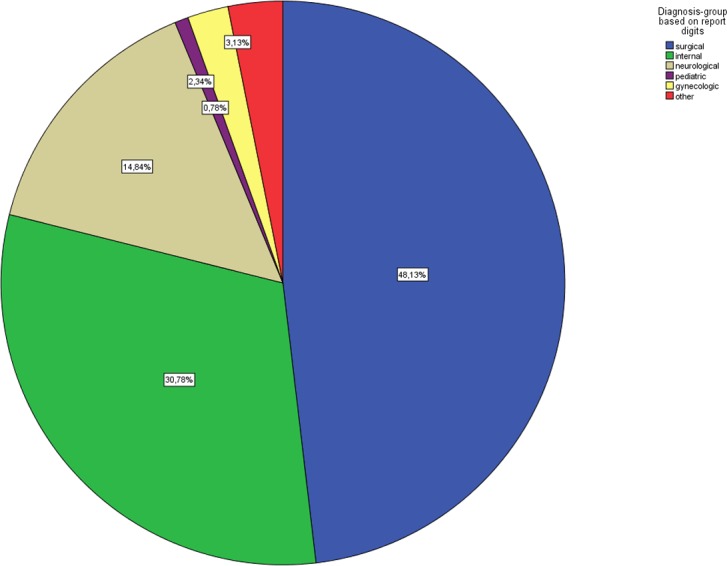
Overall range indications of the selected emergency operations.